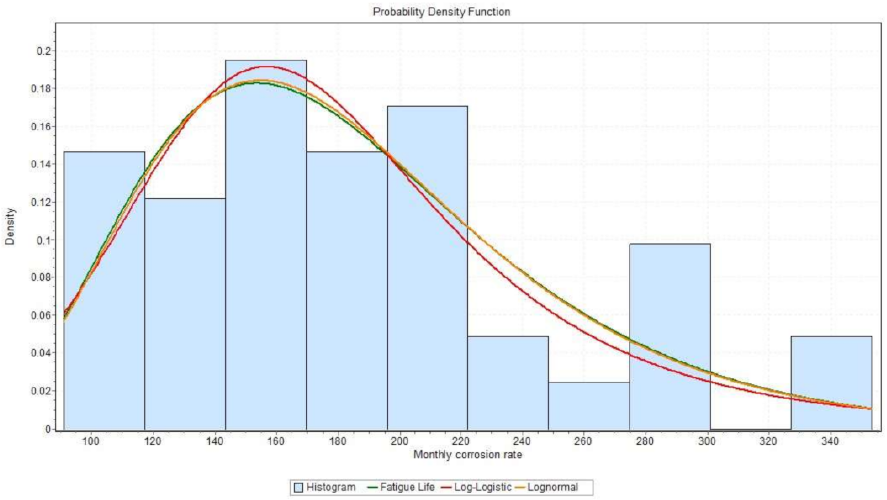
Figure 9. PDF graphics for the three best fitted two-parameter distributions for air